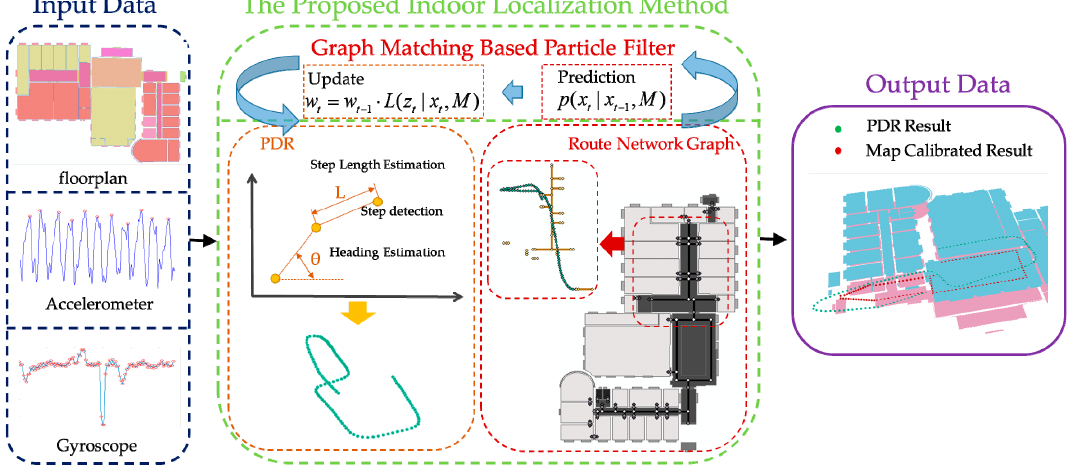
Figure 1. Overview of the framework of the semantic augmented route network-based indoor localization method proposed in this paper. PDR: pedestrian dead reckoning.